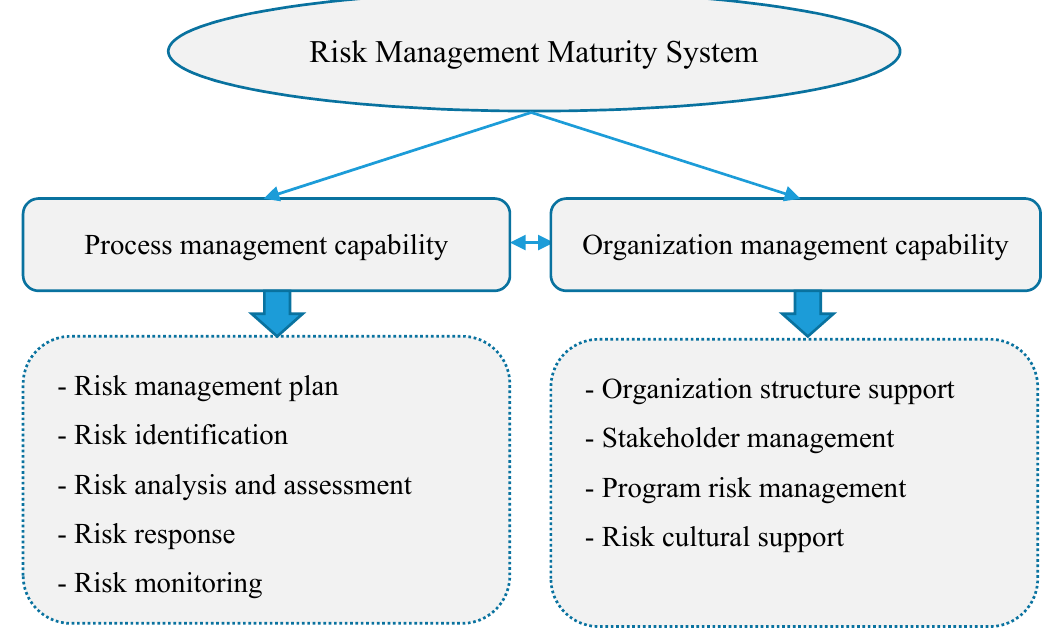
Figure 4. The capability component of the risk management maturity system (RMMS) model, Adapted from Jia et al.